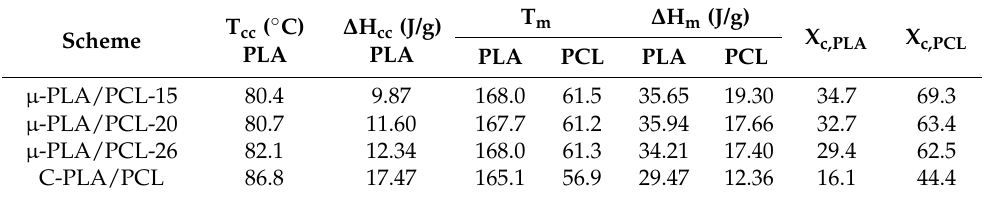
Table 3. The DSC parameters of microparts with different cavity size and